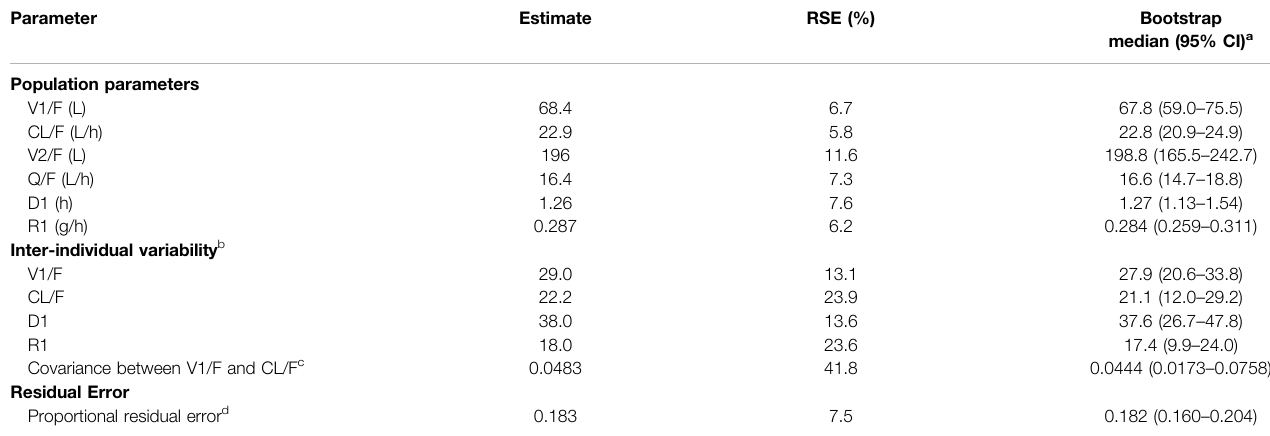
TABLE 1 | Parameter estimates and bootstrap results of the fi nal pharmacokinetic model of AST-001. Parameter